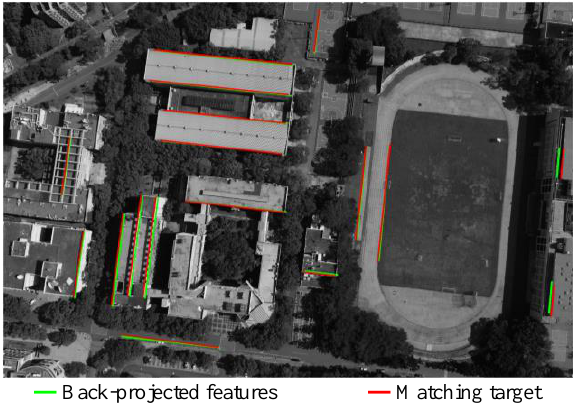
Figure 5. Back-projected features after pull-in